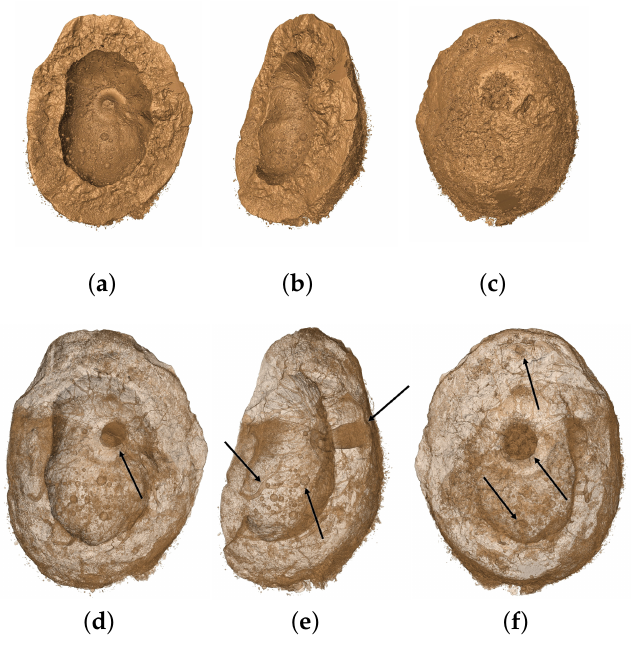
Figure 11. Crushed endocarp’s microCT scan images: opaque-colored/translucent-colored volumes’ ( a , d ) inner views, ( b , e ) lateral views and ( c , f ) outer